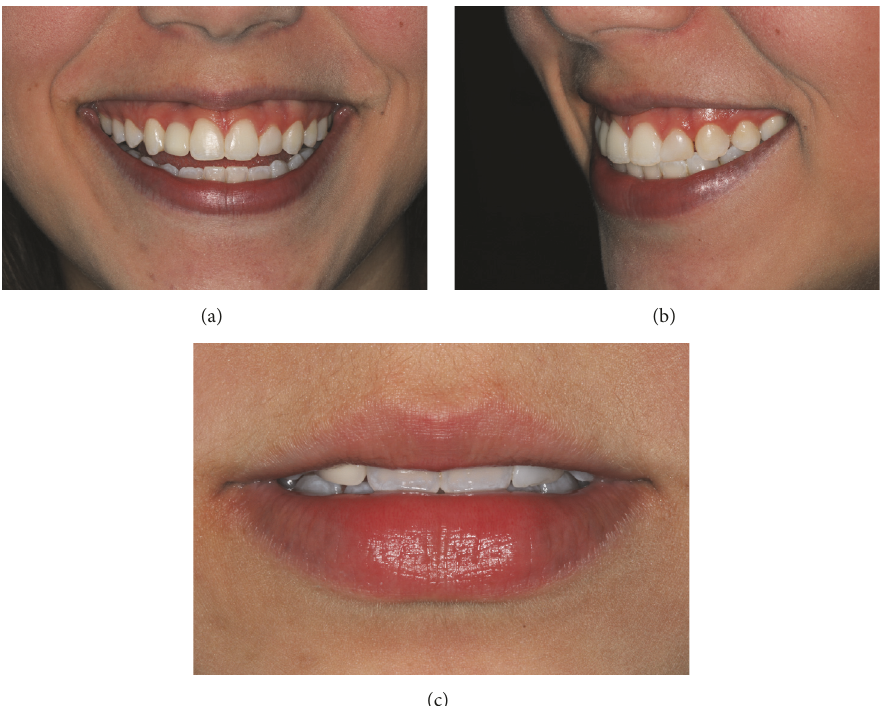
Figure 1: Initial appearance of the patient’s smile from the front (a) and lateral (b) perspectives. She was dissatisfied with the shapes, sizes, and color of her teeth. Lips at rest show the excessive opacity of the prosthesis on the right side lateral implant (c).